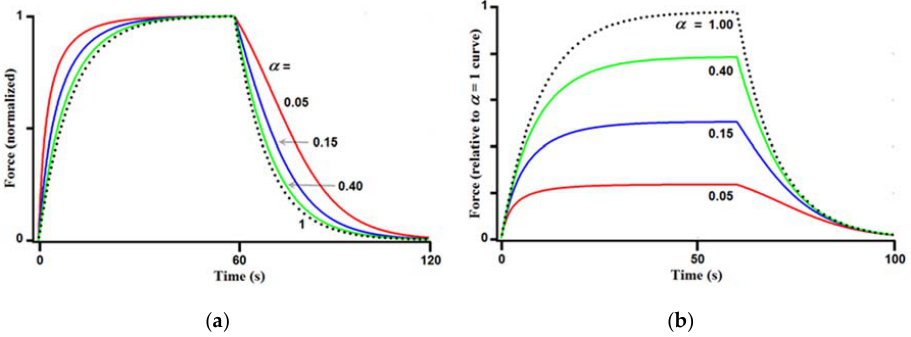
Figure 5. Transient force responses for heating a fraction α of the length of a strip with a constant power level for 60 s with convective cooling through the strip sidewalls. Keeping α a constant in the model ignores conductive spreading of heat along the length of the strip. However, this model is generalized in Section 5 by representing α as a function that varies in time. ( a ) Plotted to show that for decreasing values of α , the force waveforms (normalized to unity) have decreasing rise times and increasing fall times compared to the temperature transient; ( b ) Plotted to show that the transients saturate at lower levels of force with decreasing values of α .